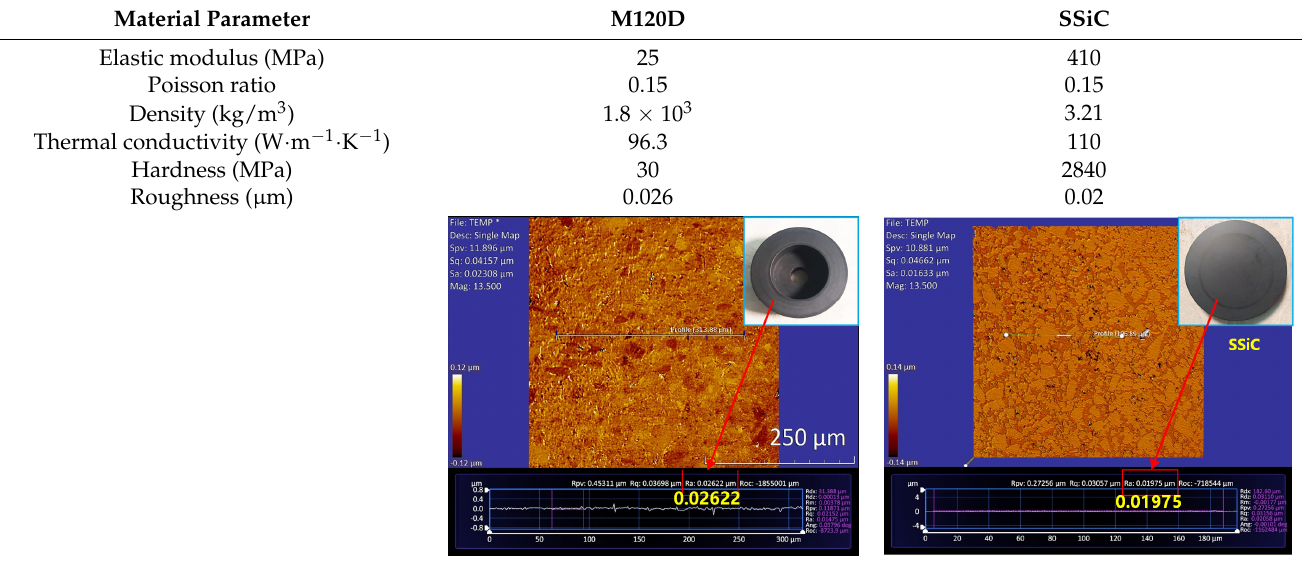
Table 1. Material properties of M120D and